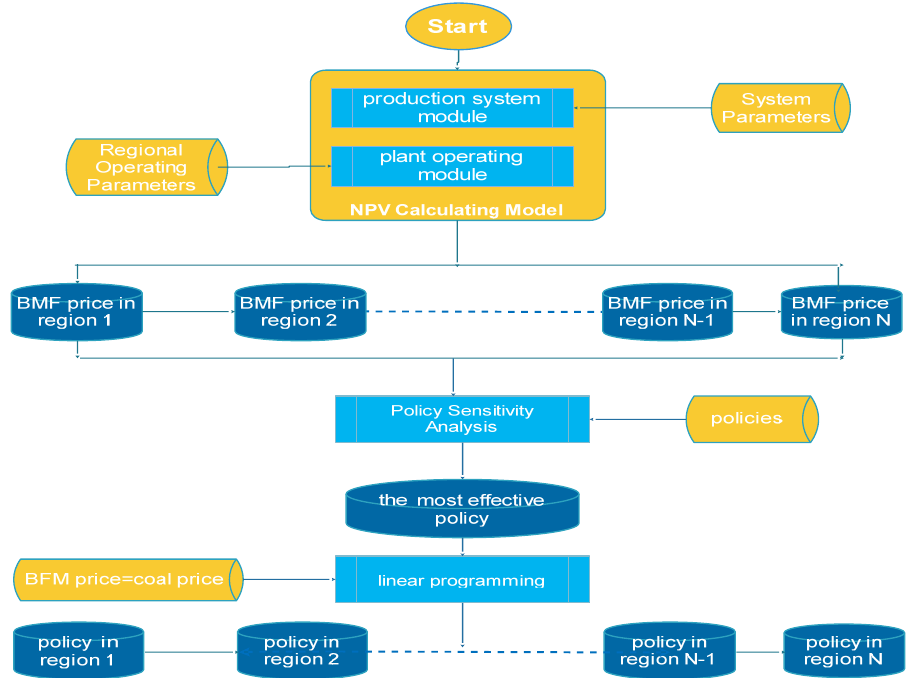
Figure 4. Flowchart of the regionalized net present value (NPV)